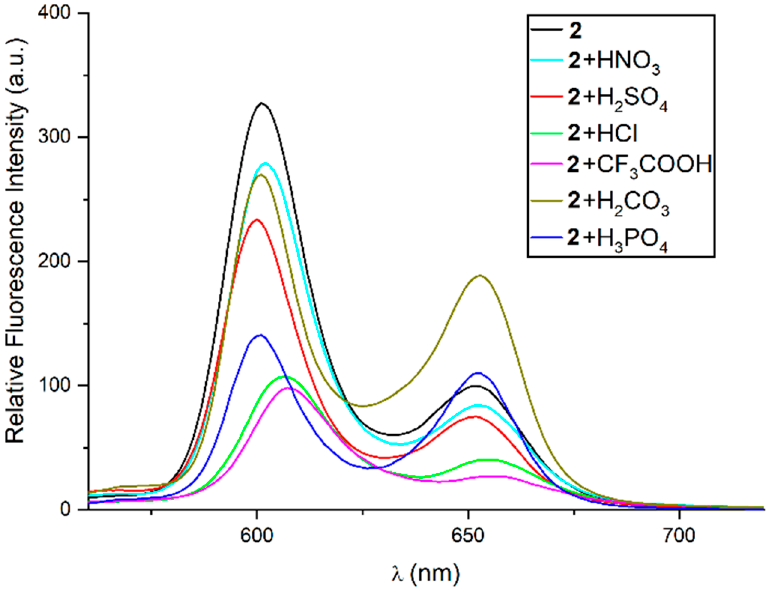
Figure 4. Fluorescence spectra of compound 2 and its different ionic complexes in CHCl 3 . OD of the sample solution was fixed at 0.20.